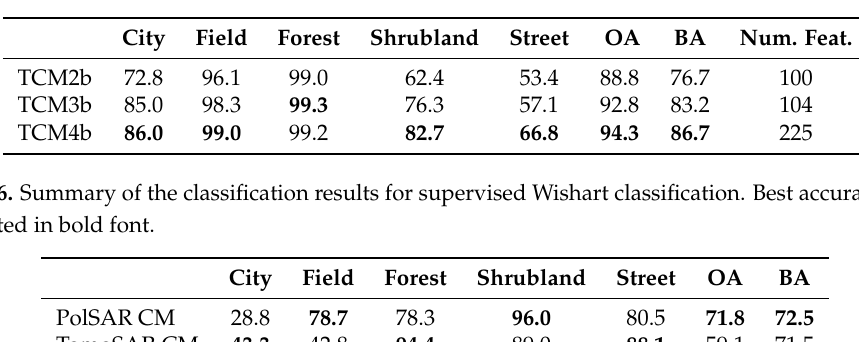
Table 5. Summary of the classification results (in percent) with TomoSAR CM for feature sets including phase. Best accuracies are indicated in bold font.